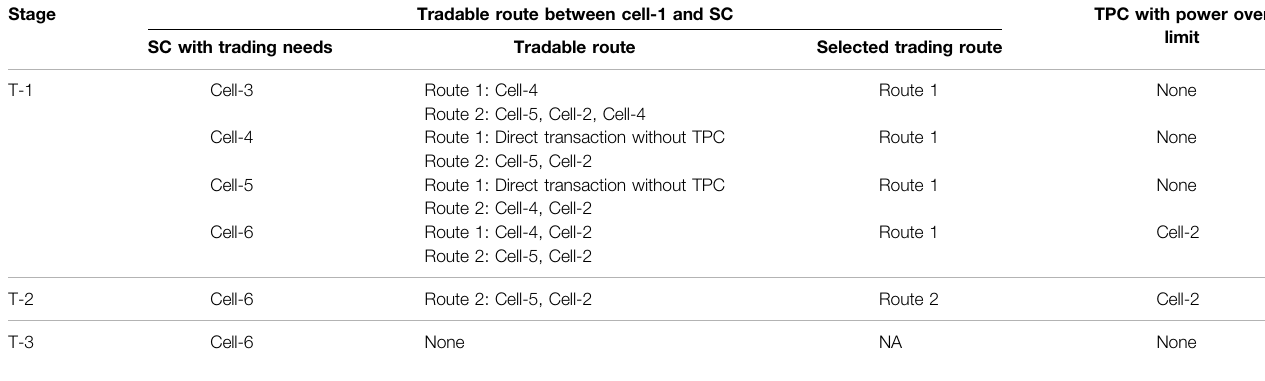
TABLE 3 | Trading route information of cell-1 at each stage of distributed economic